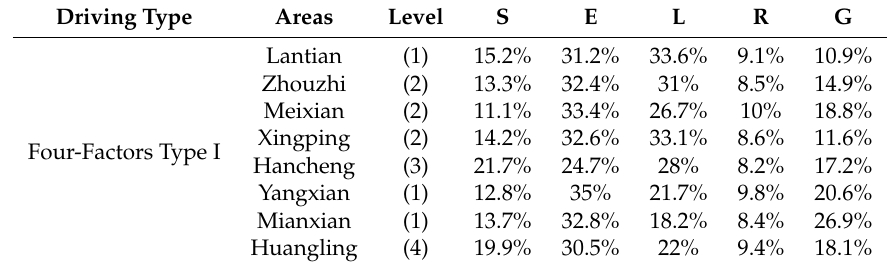
Table 9. Contribution rate of green development driving e ff ect of “Four-Factors Type I” areas. Driving Type Areas Level S E L R